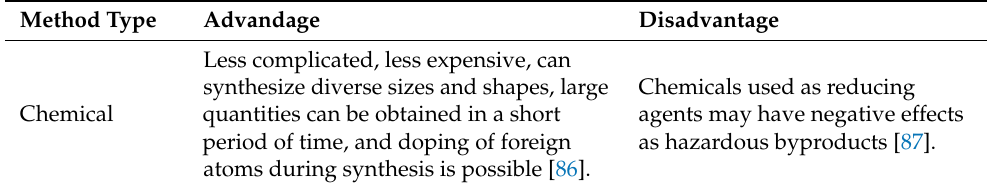
Table 5. Comparison of different techniques for bimetallic